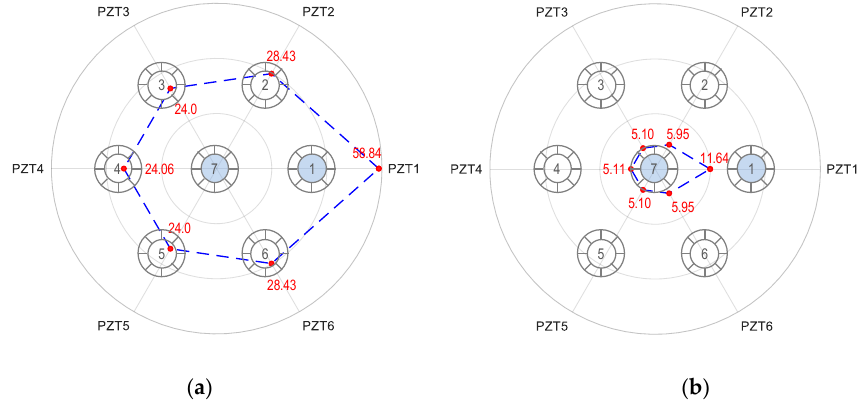
Figure 15. Linear tomography of RMSD indices (%) using all PZTs 1 – 6: Strand 7 breakage. ( a ) Peak 1’s impedance and ( b ) Peak 2’s impedance.